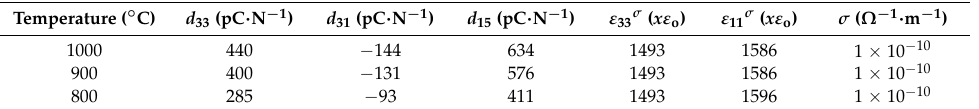
Table 3. Material coefficients for Bi 0.36 Pb 0.64 Sc 0.36 Ti 0.64 O 3 spark plasma sintered at